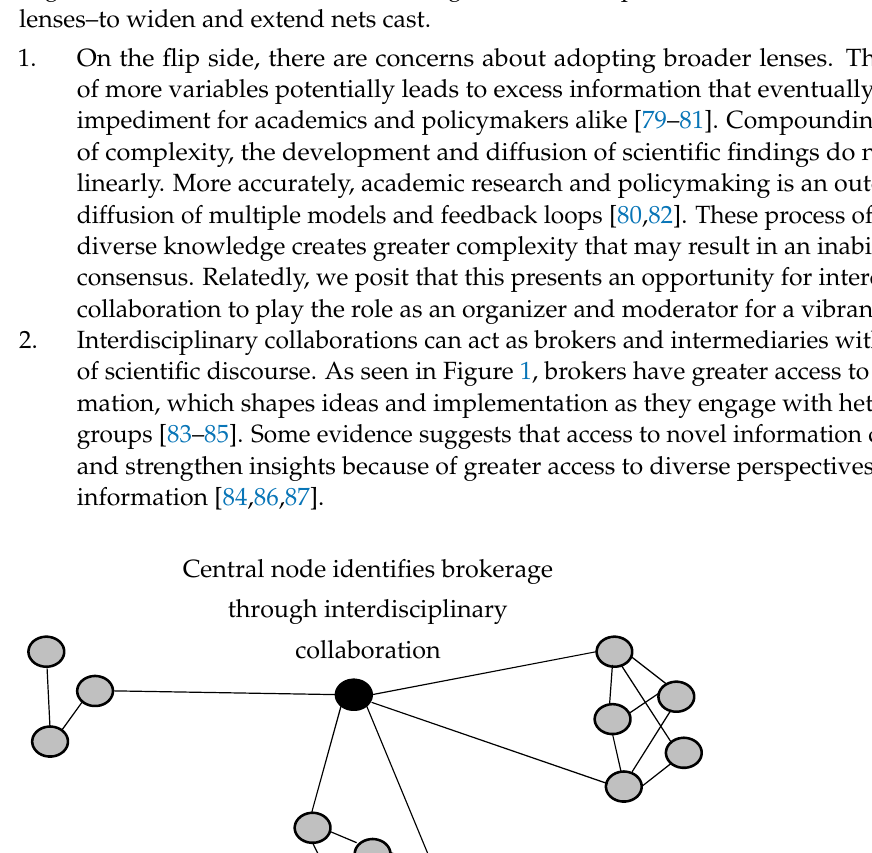
Figure 1. A Simple Illustration of Brokerage within a Network Structure.